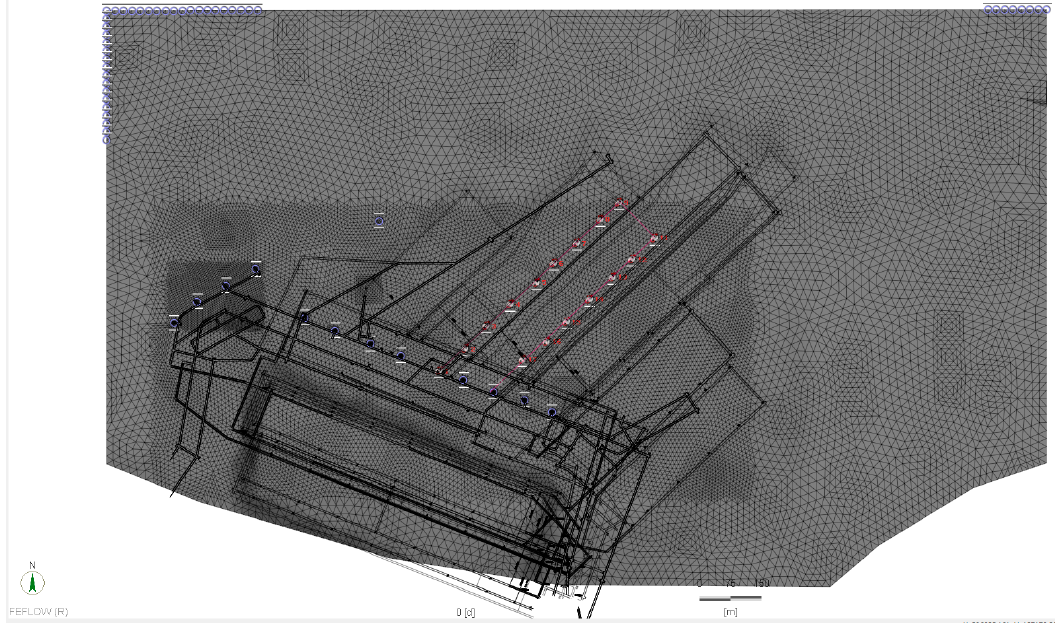
Figure 7. A Finite Elements Method (FEM) groundwater model. The active dewatering drive ‐ in wells are depicted using red points, the surface wells and inflow into the model on the north were modelled with Dirichlet b. c. (blue points).